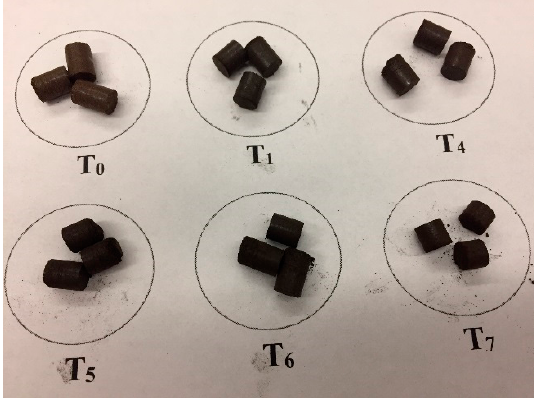
Figure 2 . Pellets from untreated and carbonized feedstock. Figure 2. Pellets from untreated and carbonized feedstock. Table 4. Hardness and durability of